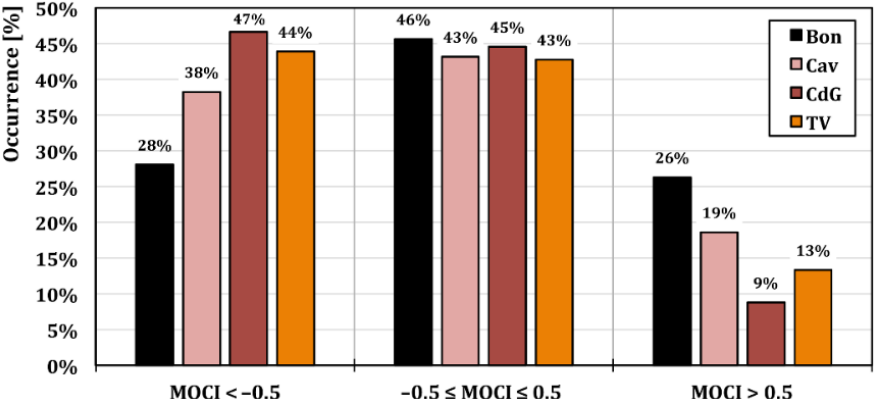
Figure 8. Occurrence of the main MOCI ranges for the four ARPA stations. Occurrences are calculated using diurnal (from 06:00 to 19:00 LT) hourly data.